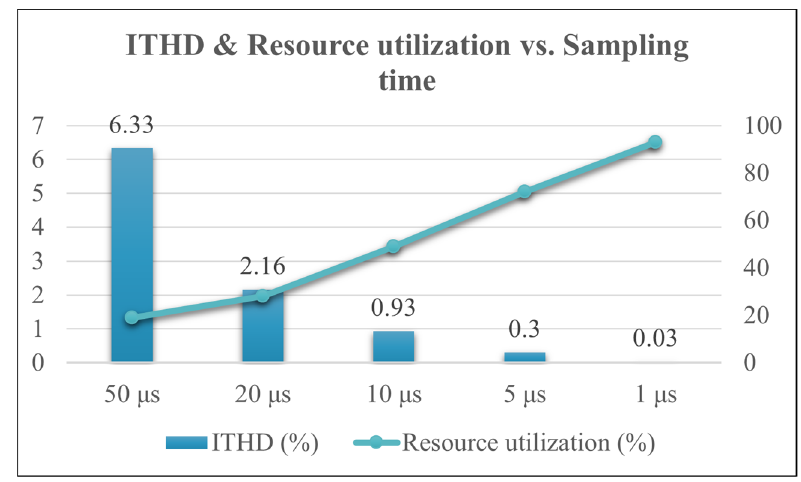
Figure 15. Comparison results of ITHD and resource utilization for different sampling intervals.